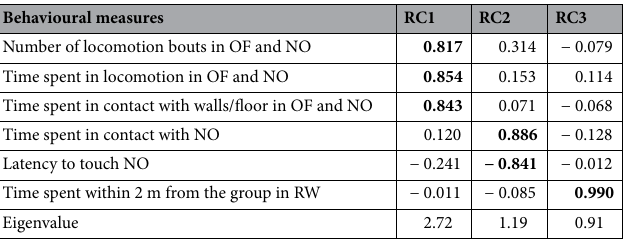
Table 1. Loadings of the behavioural measures on the 3 main rotated components (RCs). Loadings rated ‘excellent’ (i.e. (|values| > 0.71) are written in bold. NO Novel-object, OF Open-field, RW